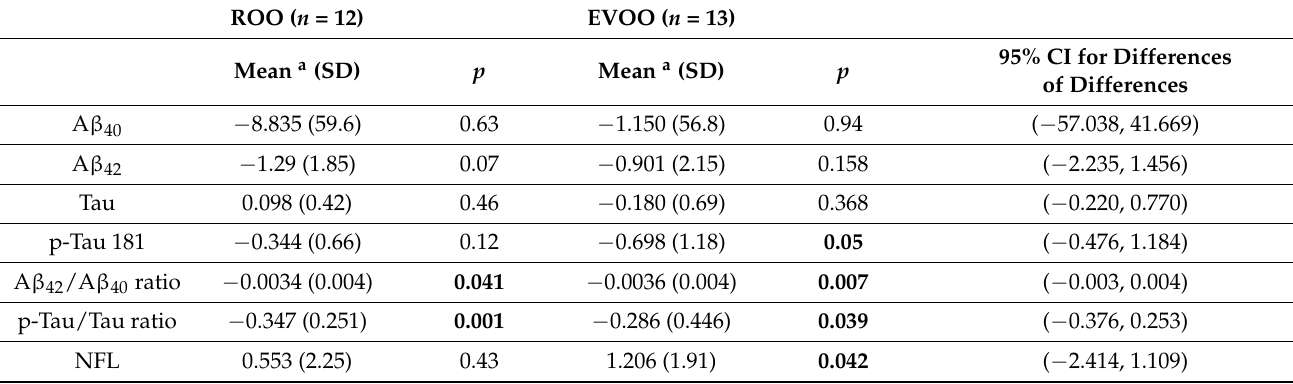
Table 5. Changes in AD blood biomarkers after 6 months of olive oil